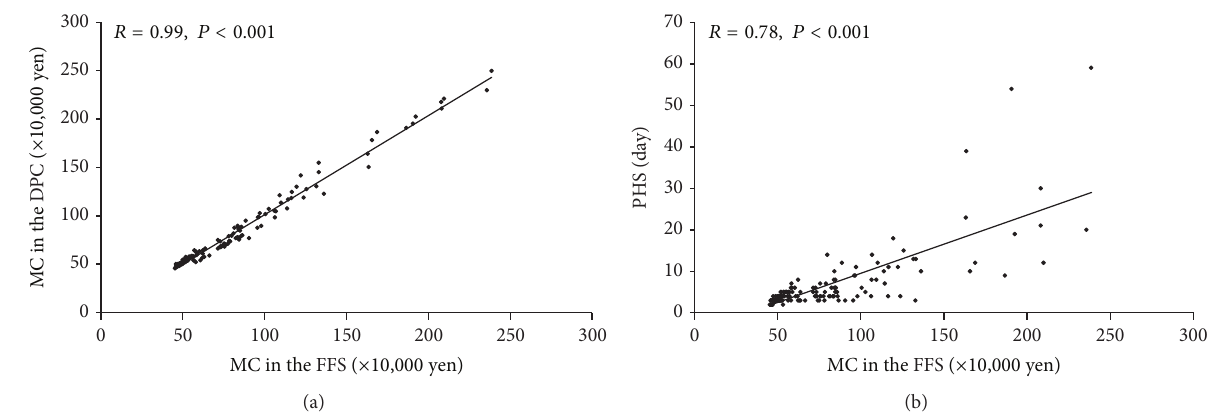
Figure 4: (a) Relationship between MC in the FFS system and MC in the DPC system ( 𝑛 = 171 ). (b) Relationship between PHS and MC in the